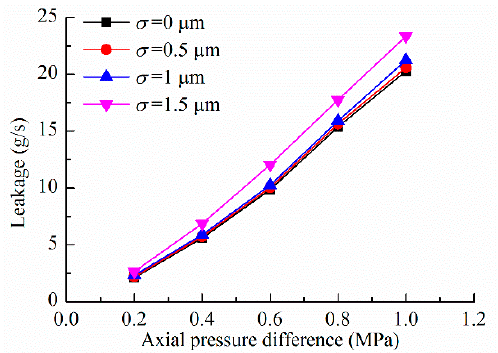
Figure 14. Effect of side leakage flow on the leakage of 2SFS.